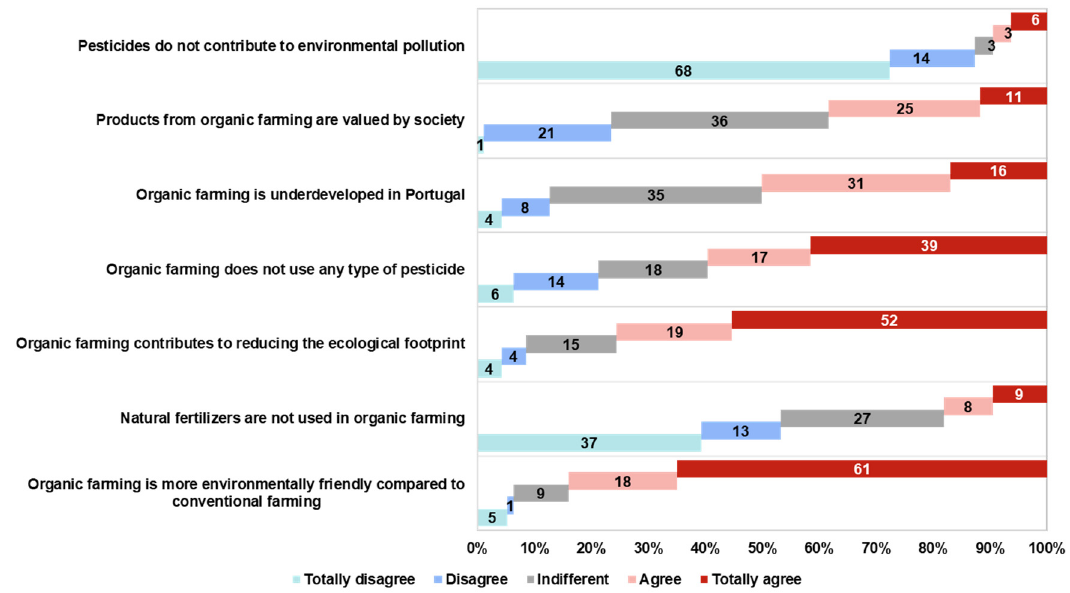
Figure 1. Level of agreement with the statements used to assess knowledge about OF.